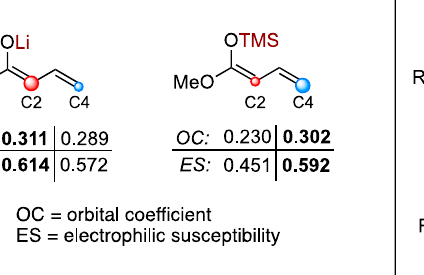
Figure 1. Intrinsic reactivity of different types of dienolates.